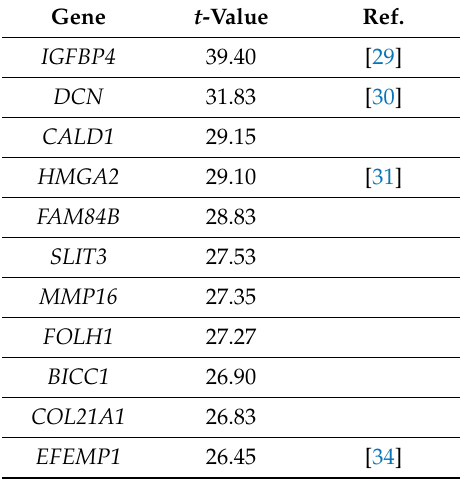
Table 2. The top 15 up-regulated genes in EPZ-011989-treated tumor samples according to the t -value statistics; eight of them have an association with cell survival pathways, as described in the quoted